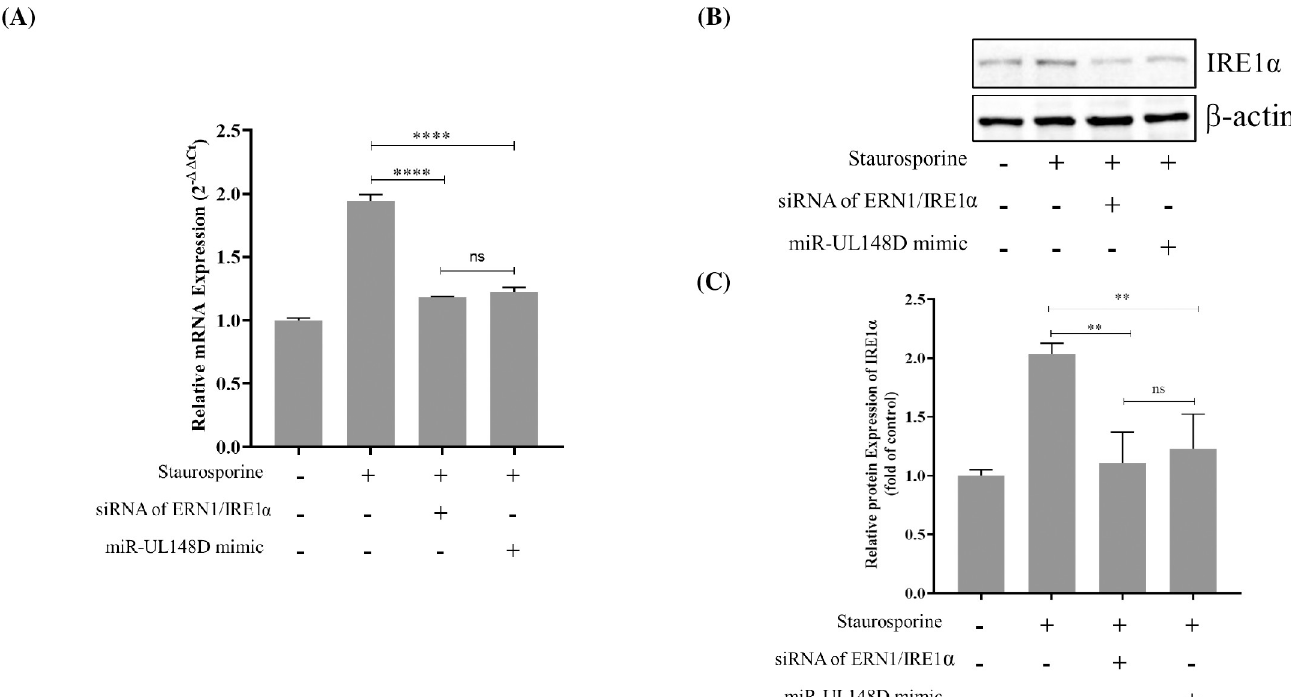
Fig 6. Comparison of downregulation of ERN1 by siRNA of ERN1 and hcmv-miR-UL148D: (A) ERN1 mRNA downregulation: The relative expression levels of ERN1 mRNA after the transfection of either hcmv-miR-UL148D and siRNA of ERN1 were measured through qRT-PCR. Results were expressed as the fold change (2 − ΔΔ Ct ) ( ± SEM; ���� , p < 0.0001; ns = non-significant). ( B & C ) IRE1 α protein encoded by ERN1 downregulation: The IRE1 α protein downregulation after transfection with either siRNA of ERN1 and hcmv-miR-UL148D were analyzed through Western blot. The relative IRE1 α protein quantification was performed through ImageJ software after normalizing with β -actin. Experiments were performed in triplicates (S2 Fig), and the data from three different experiments were used for statistical analysis ( ± SEM; �� , p < 0.01, ns = non-significant).